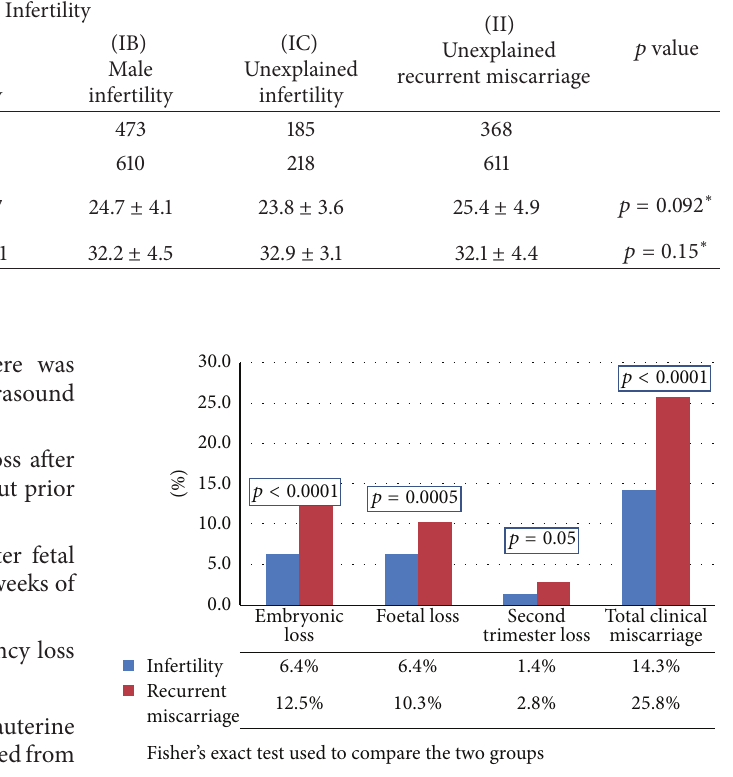
Figure 1: A comparison of the rates of pregnancy loss between women with infertility and recurrent